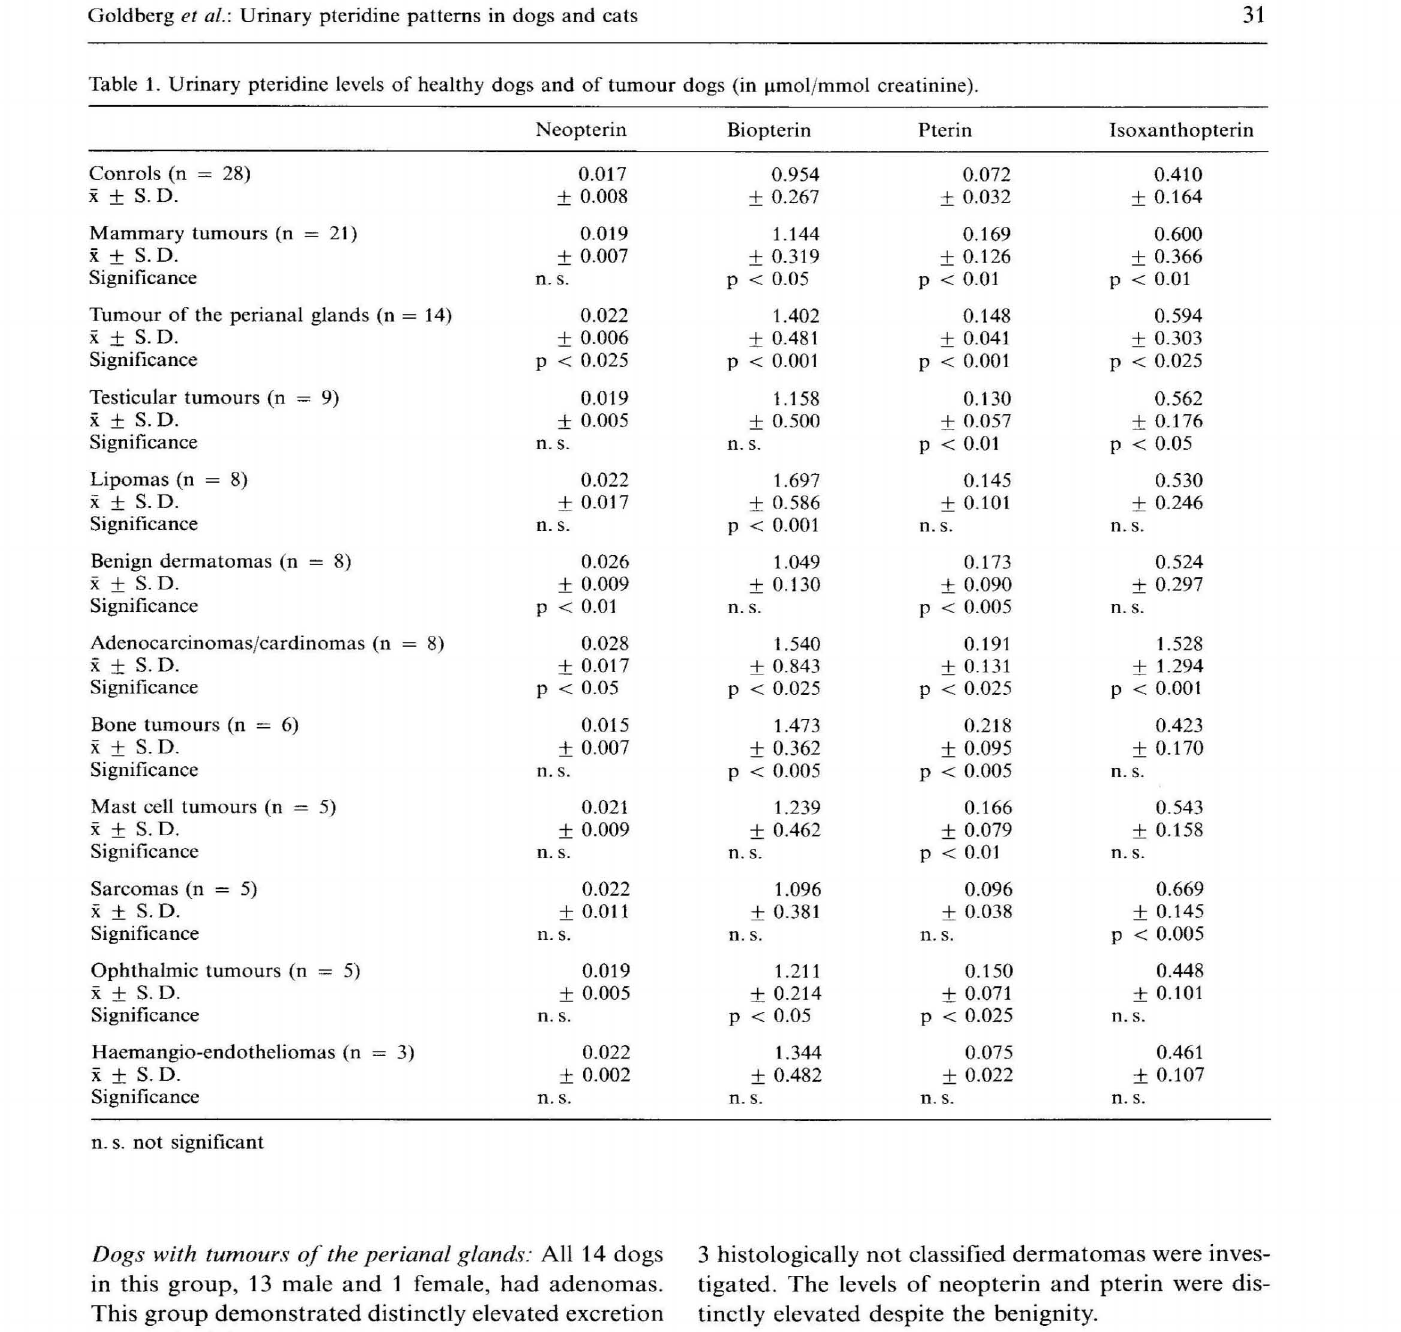
Table 1. Urinary pteridine levels of healthy dogs and of tumour dogs (in Ilmol/mmol creatinine). Conrols (n = 28) 0.017 x ± S.